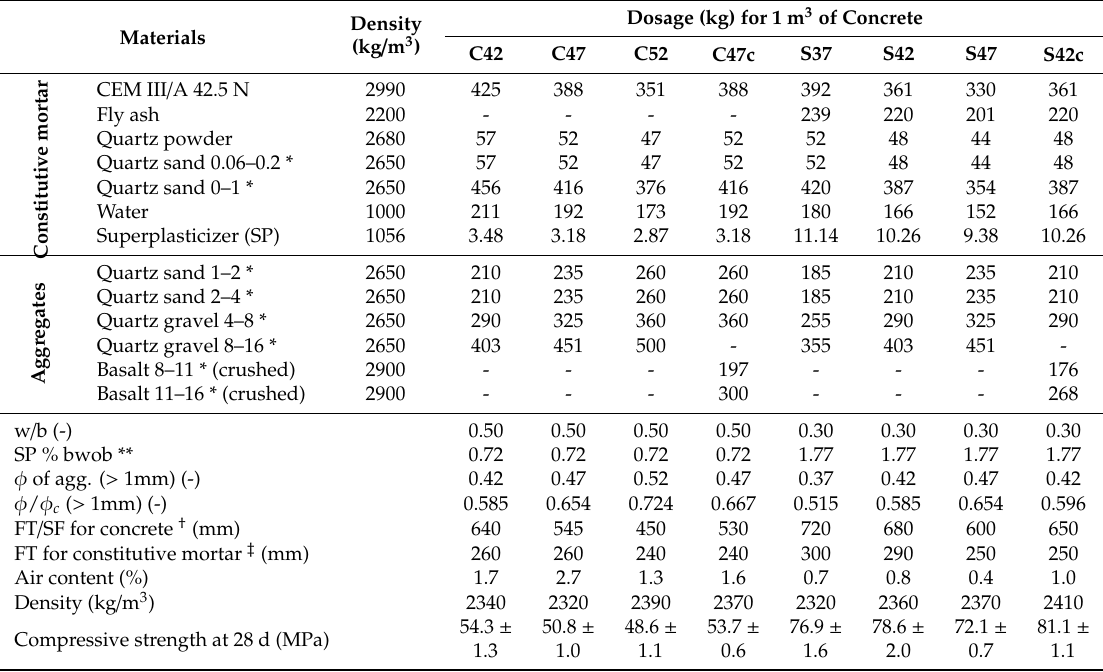
Table 1. Compositions of concretes under investigation and their constitutive mortars as well as the concretes’ properties in the fresh and hardened states.